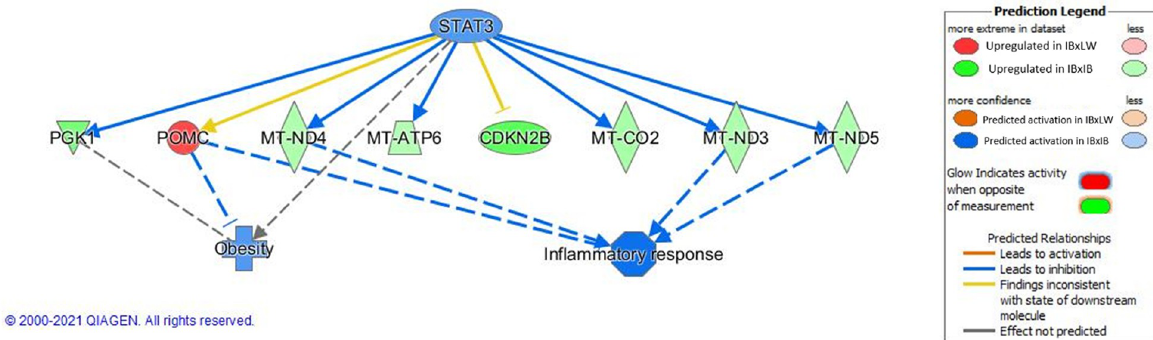
Fig 3. Causal network predicted for STAT3 regulator showing its relationship with obesity and inflammatory response, obtained using Ingenuity Pathway Analysis (IPA). IBxIB = pure Iberian pigs; IBxLW = Iberian x Large White crossbreds.